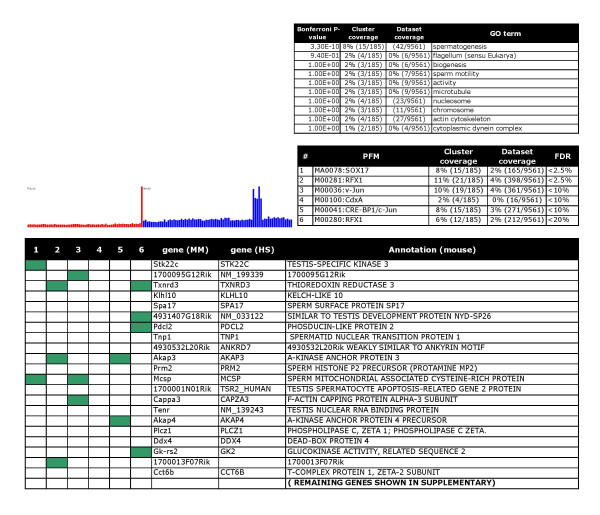
Testis selective battery: Over representation of RFX and SOX17 motifs indicates new roles for these factors as coordinators of testis selective gene expression. Tables and charts are organized as in figure 2.